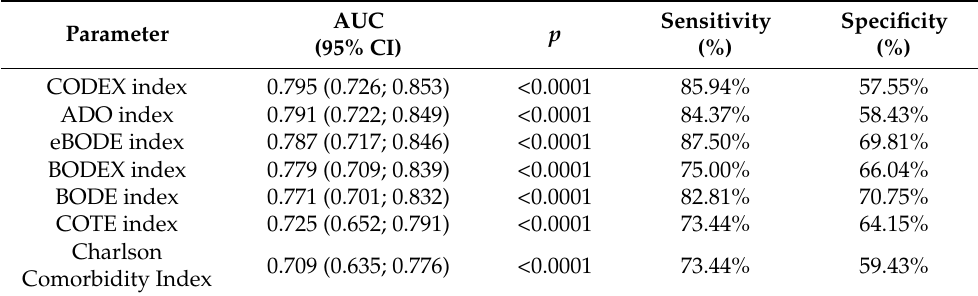
Figure 4. Kaplan–Meier curve plot for ADO and BODE index in estimating 10-year survival. Note: Quartile 1 is a score of 0 to 2, quartile 2 is a score of 3 to 4, quartile 3 is a score of 5 to 6 and quartile 4 is a score of 7 to 10. Table 3. Results of receiver operating characteristic (ROC) curve analysis for 5-year survival.